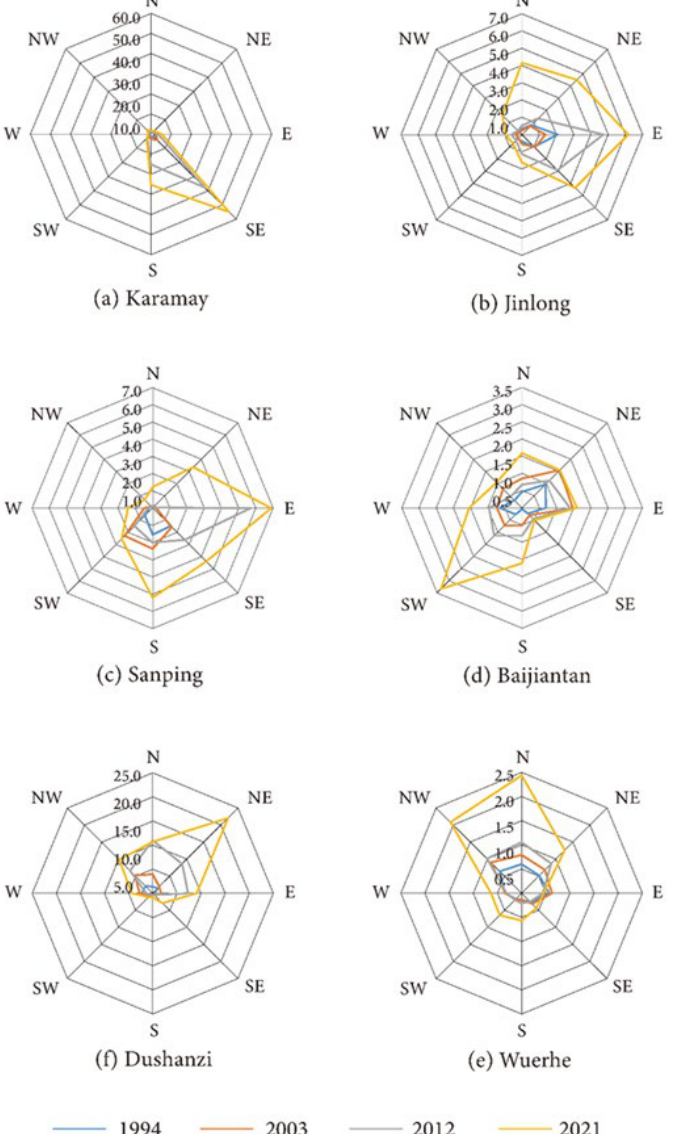
Figure 5. Orientation of urban construction land expansion at each township in 1994, 2003, 2012, and 2021.